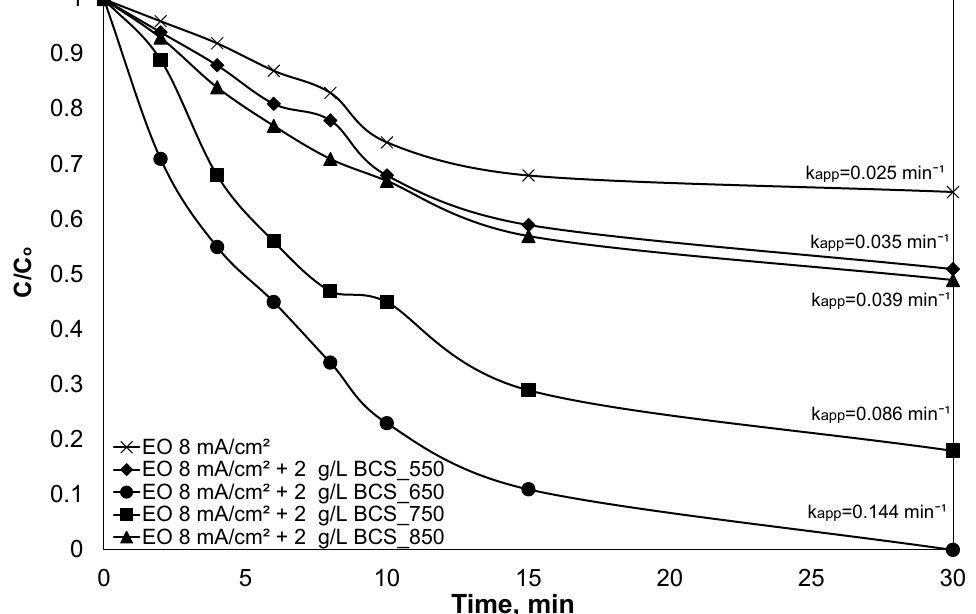
Figure 4. Effect of biochar type on the degradation of SMX in the combined 3D process. Conditions: [SMX]° = 500 μ g/L, [BCS_x] = 2 g/L, [Na 2 SO 4 ] = 0.1 M, j = 8 mA/cm 2 , ultrapure water.